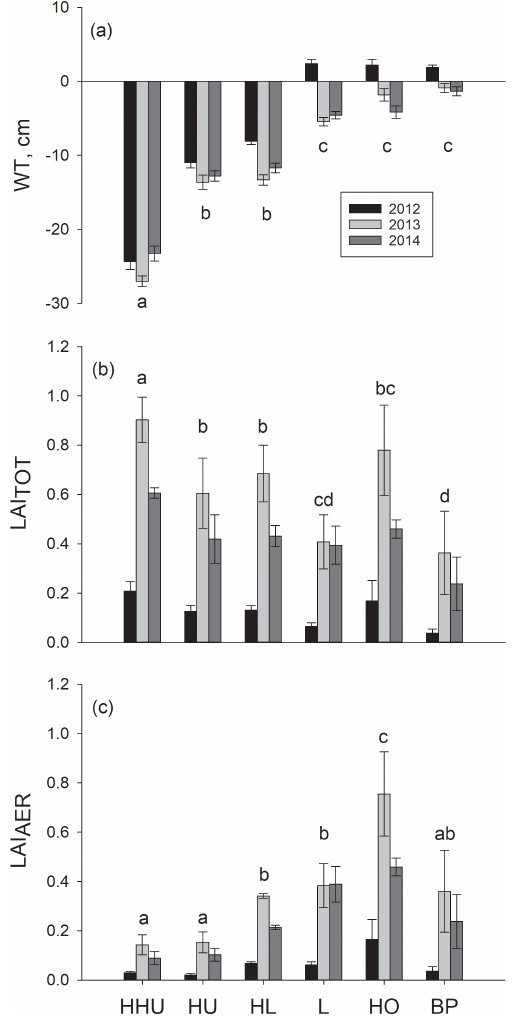
Figure 1. (a) Mean water table and the mean of summer maximum of (b) total leaf area (LAI TOT ) and (c) leaf area of aerenchyma- tous plant species (LAI AER ) in six plant community types: high hummock (HHU), hummock (HU), high lawn (HL), lawn (L), hol- low (HO) and bare peat surface (BP) in three subsequent years. The error bars show the standard error of the mean. The different letters (a–d) denote significant differences between the plant com- munity types. The same letter above bars indicates that those plant community types do not differ statistically from each other. Note: statistical analyses for LAI have been conducted with mean LAI TOT and LAI AER instead of summer maximum.